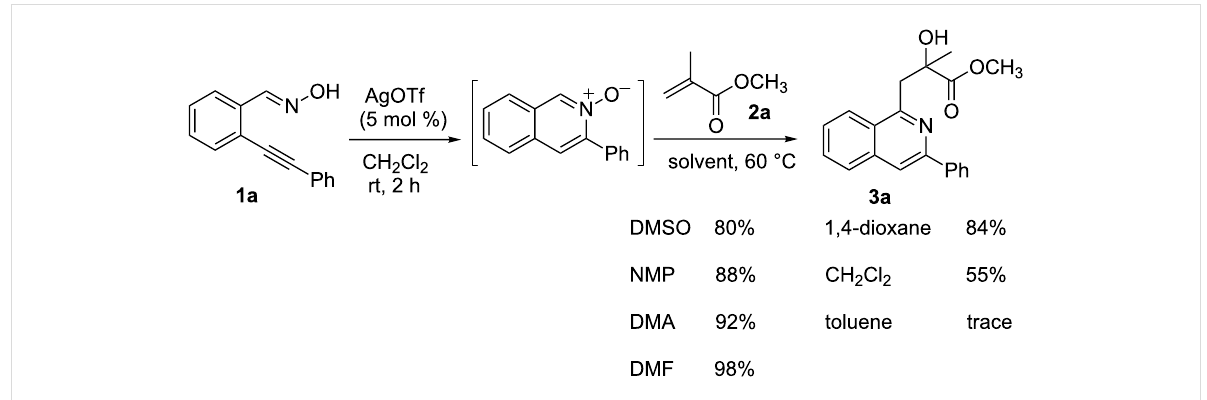
Scheme 2: Synthesis of 1-alkylated isoquinoline 3a by a AgOTf-catalyzed one-pot reaction in different